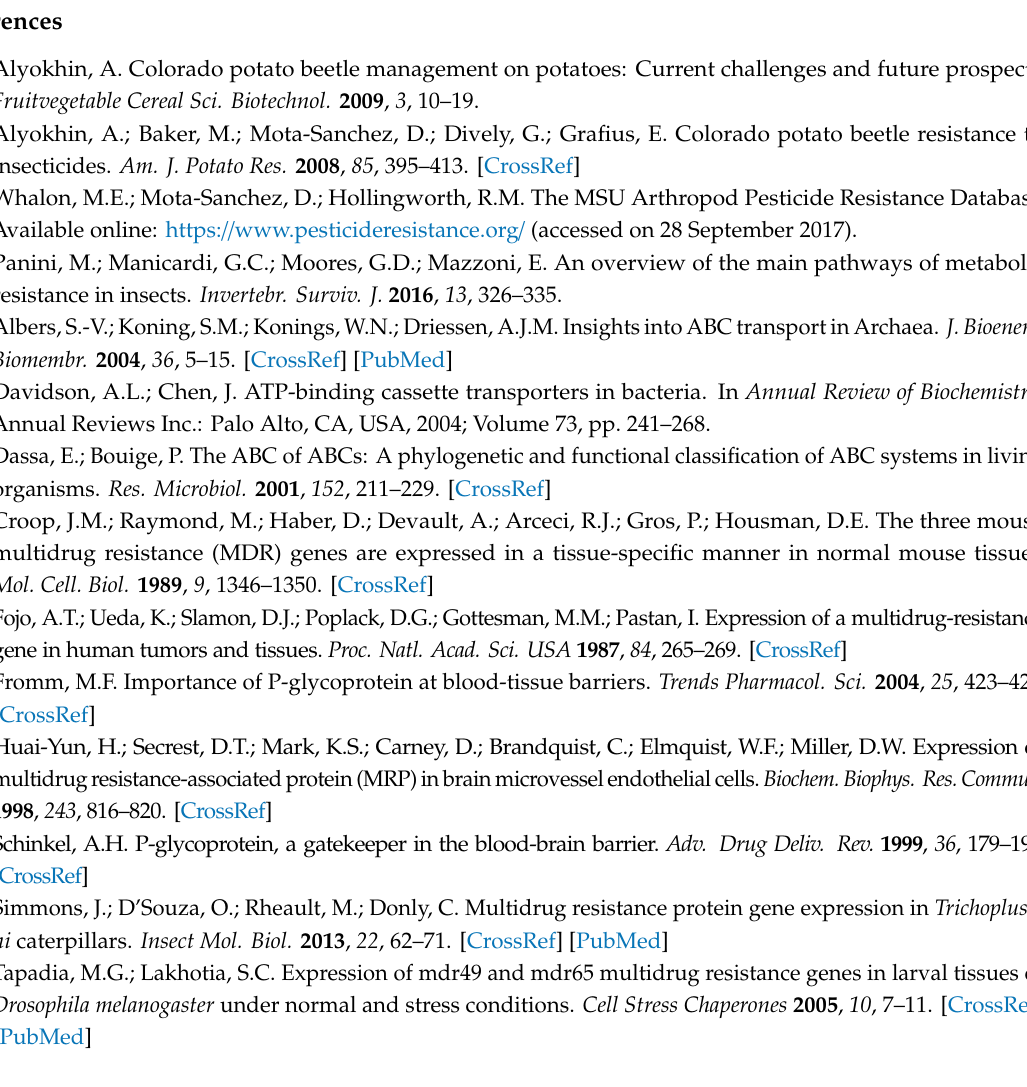
Figure S1: Comparison of extracted total RNA from induced and noninduced bacterial cultures verifying success of dsRNA fragment synthesis. Table S1: Raw qRT-PCR data for measurement of relative expression levels of each MDR gene in each tissue tested. Table S2: Raw qRT-PCR data for measurement of relative expression levels of MDR genes in silencing experiments. Table S3: Raw survival data for an ivermectin toxicity screen performed on adult L. decemlineata